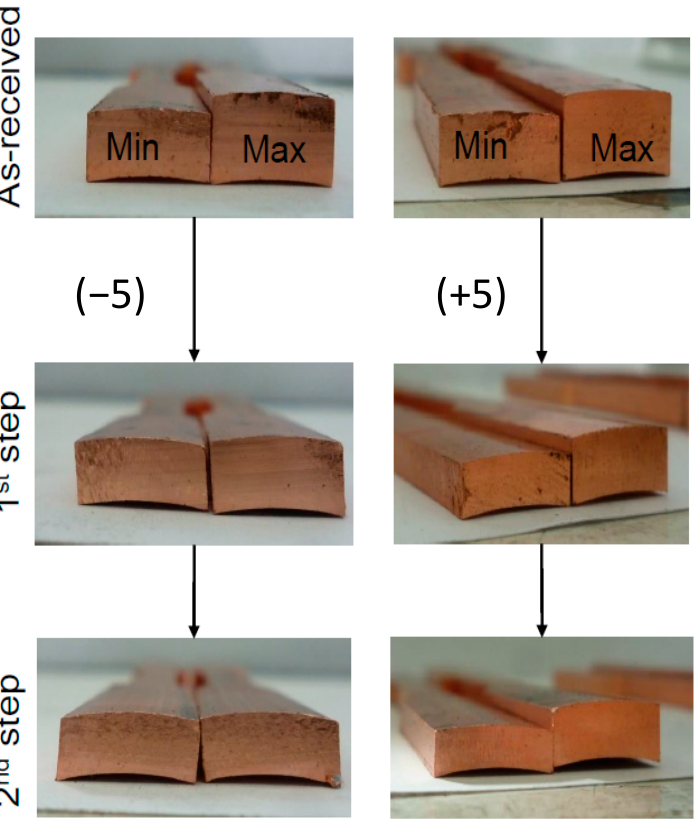
Figure 8. Max and Min after two drawing steps with dies tilted ±5° [21].